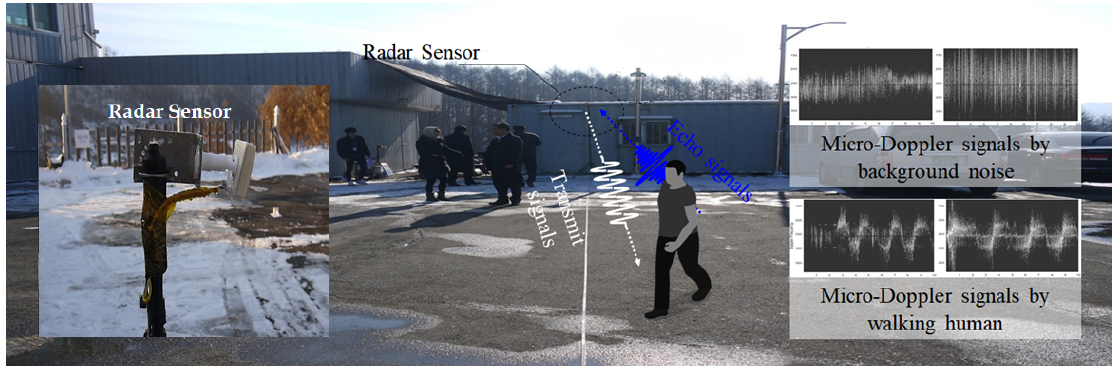
Figure 5. The experimental setup: the radar was installed outdoors to collect various background noise.